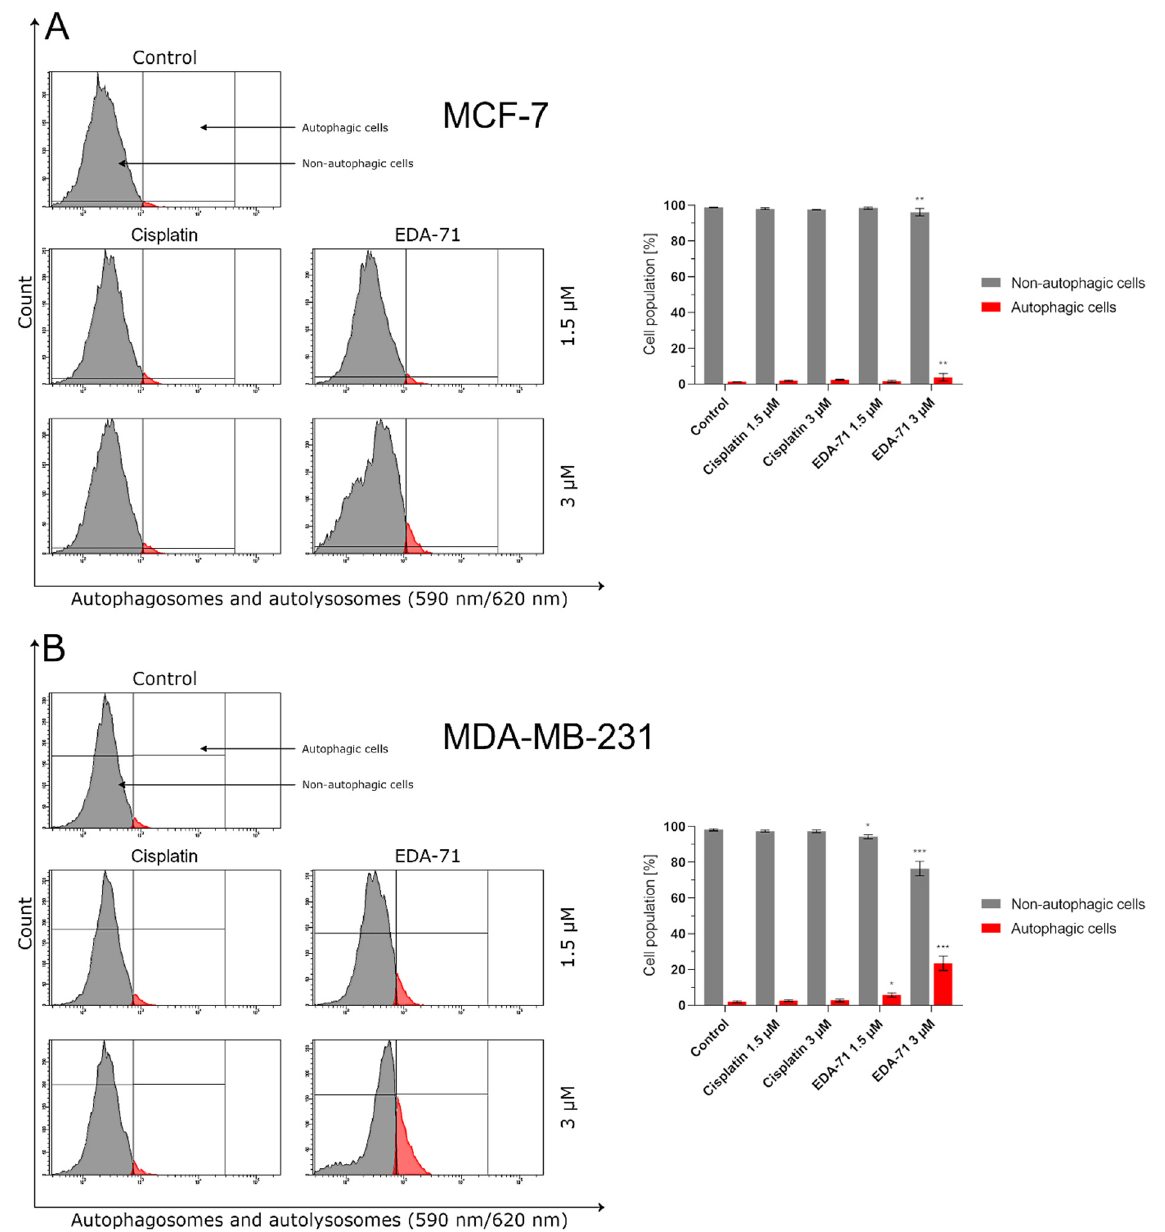
Figure 11. Induction of autophagy in MCF-7 ( A ) and MDA-MB-231 ( B ) breast cancer cells incubated for 24 h with EDA-71 and cisplatin (1.5 and 3 µM). The experiment was performed using Autophagy Probe staining and a flow cytometer. Results are presented as mean values ± SD obtained from three independent experiments ( n = 3) conducted in triplicate. Statistical differences between the experimental (treated cells) and control (untreated cells) groups were determined using one-way ANOVA followed by Dunnett’s test. * p < 0.05 vs. control group, ** p < 0.01 vs. control group, *** p < 0.001 vs. control group.